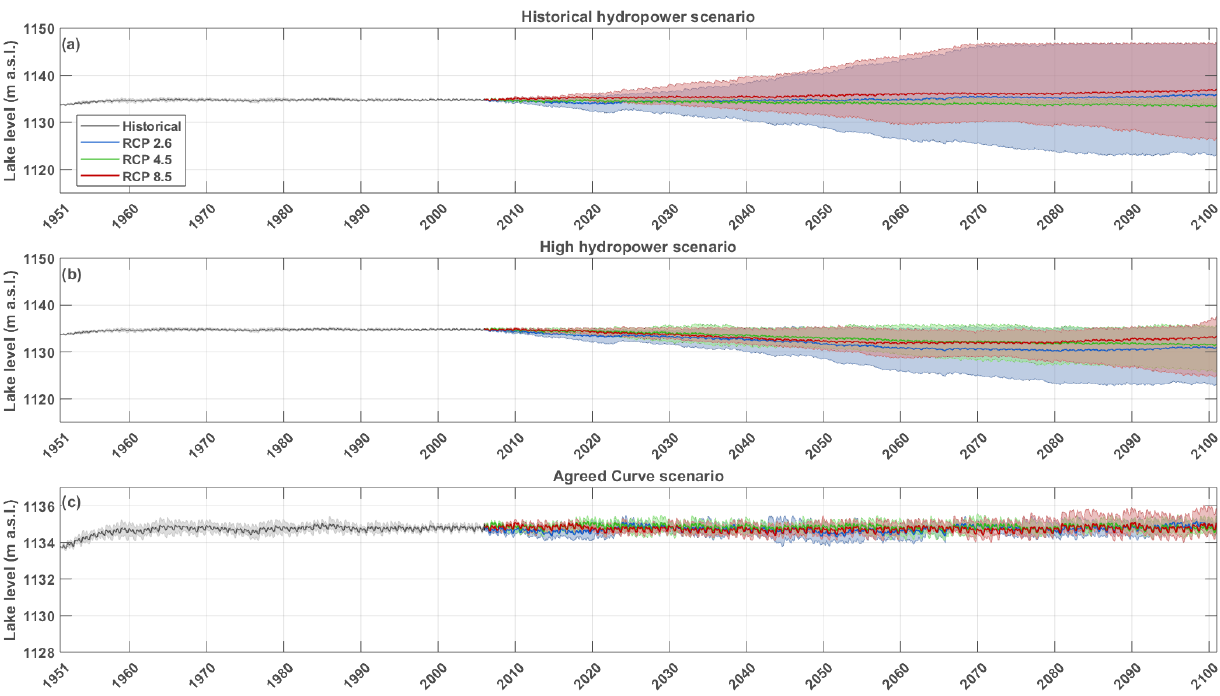
Figure C1. As in Fig. 8, but the envelope shows the interquartile range of the CORDEX